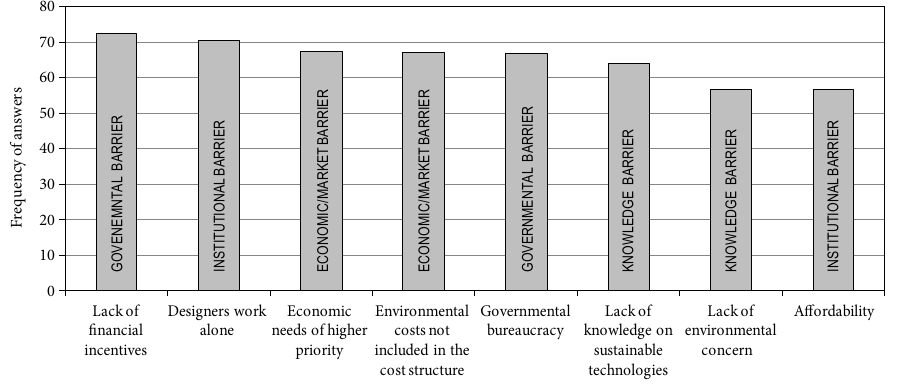
Fig. 6. Main two barriers per